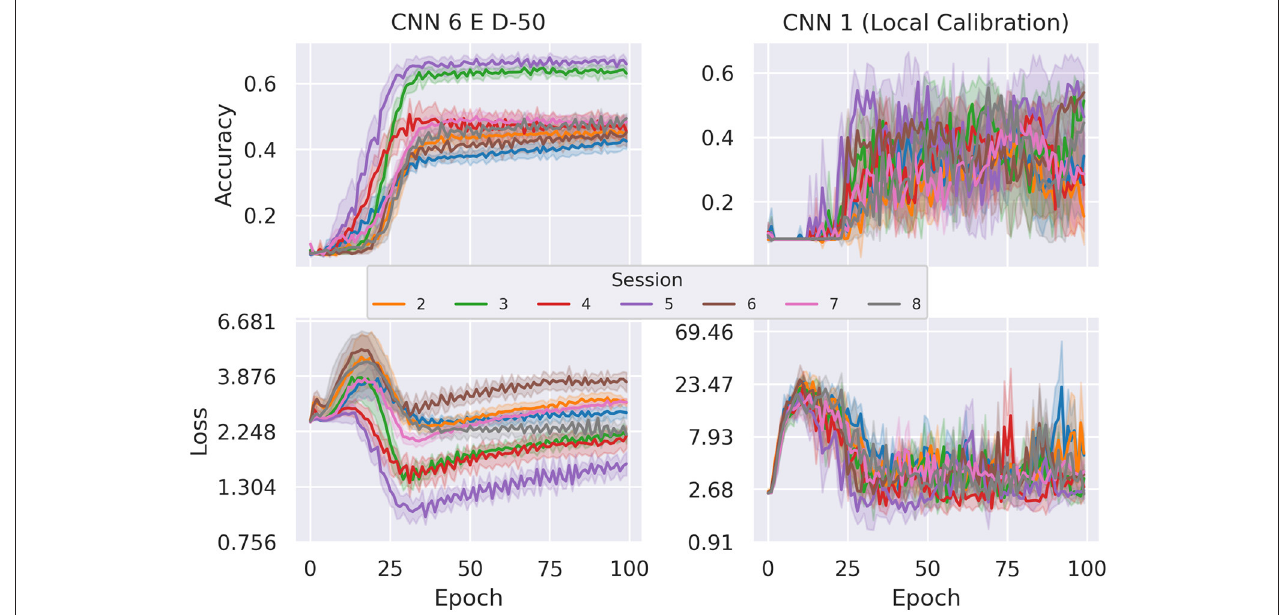
FIGURE 14 | Comparison of average cross-session test accuracy and loss on holdout sessions of subject E between dual input and local calibration single input network. This depiction clearly shows that the dual input model’s test accuracy and loss are more stable. The error bands depict the 95% confidence